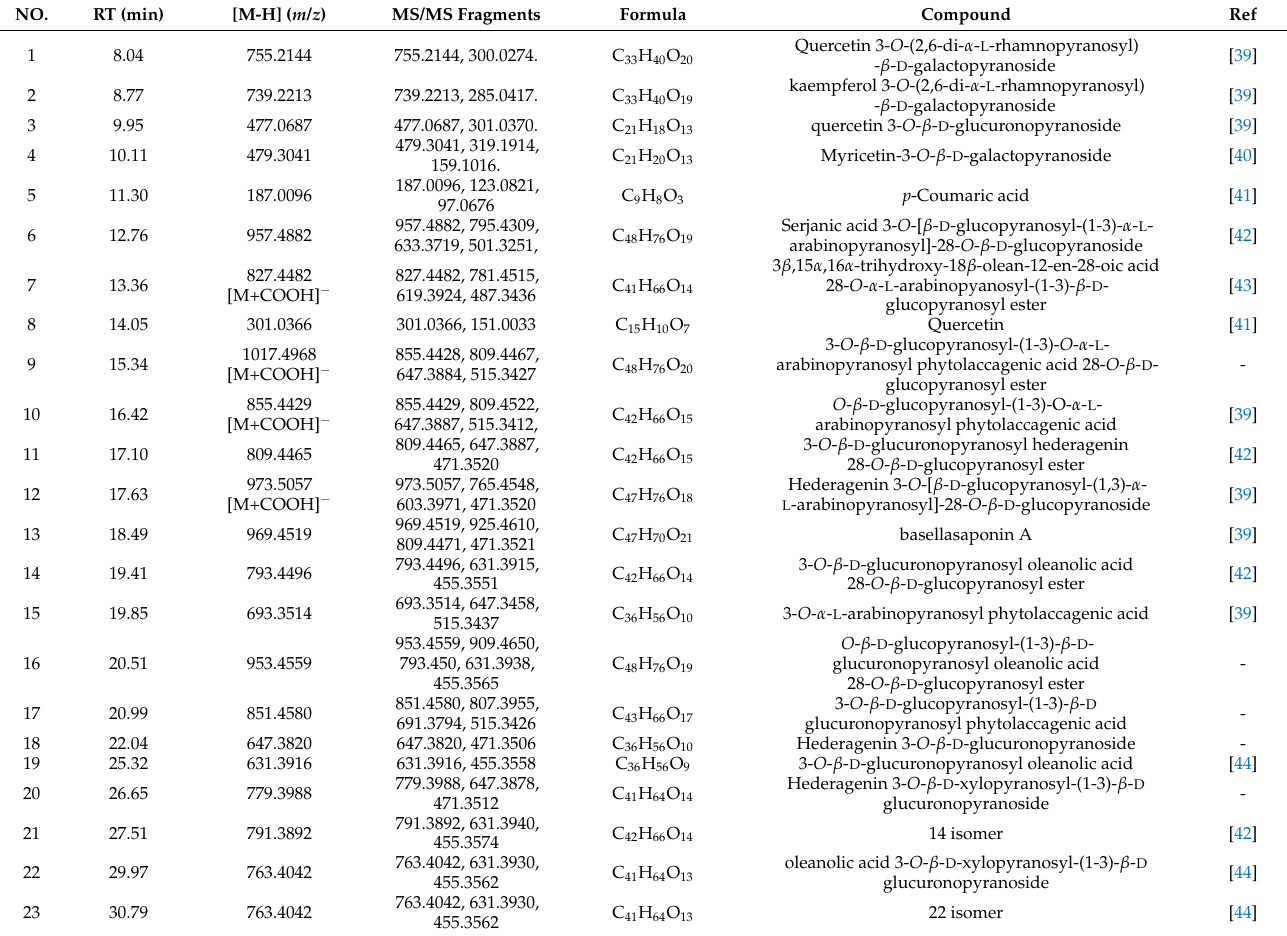
Table 4. Twenty-three compounds identified from the extracts of quinoa husks by